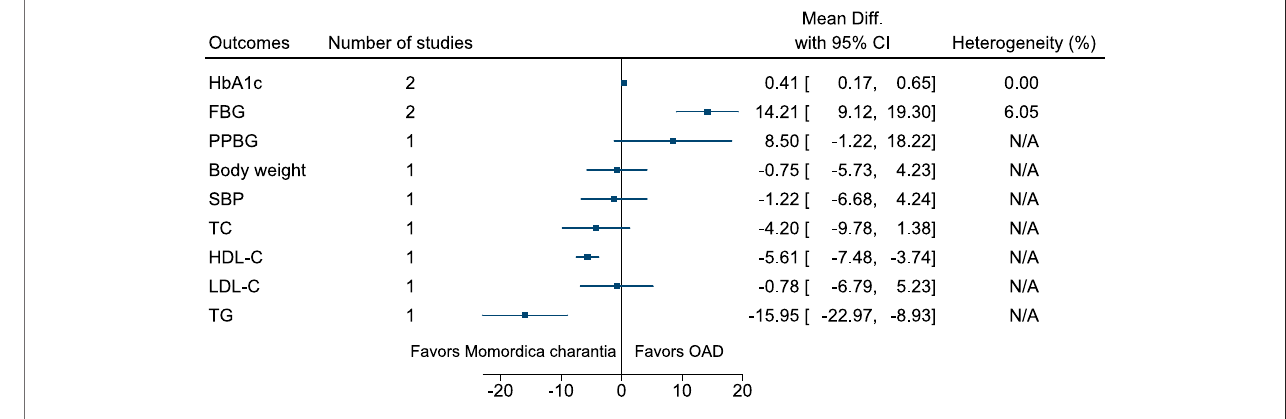
FIGURE 23 | Momordica charantia (versus OAD) — Summary forest plot.